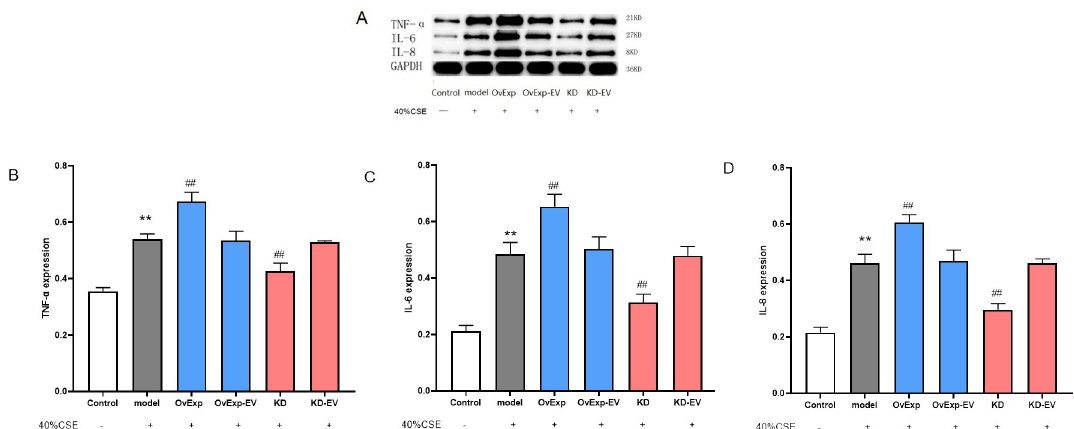
Fig 5. IL-1 β regulated the expression of TNF- α , IL-6 and IL-8. The expression levels of TNF- α , IL-6 and IL-8 were significantly increased after CSE administration, which were downregulated upon IL-1 β knockdown. Representative western blot image of the qualitative expression of TNF- α , IL-6 and IL-8 (A) The quantitative expression of TNF- α (B), IL-6 (C) and IL-8 (D) were calculated with GAPDH as an internal control. Results are represented as Mean ± S.E.M. �� P < 0.01 vs control; # P < 0.05, ## P < 0.01 vs model (n = 5). OvExp: overexpression; OvExp-EV: overexpression empty vectors; KD: knockdown; KD-EV: knockdown empty